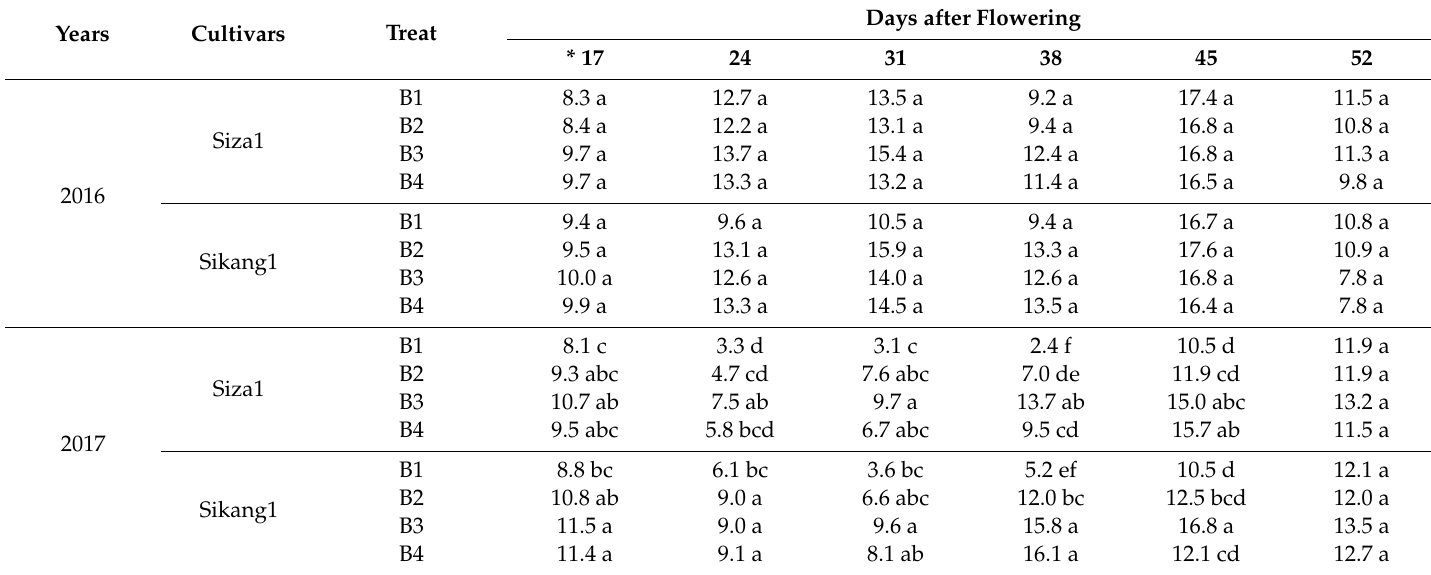
Table 6. E ff ects of the ratio of nitrogen, phosphorous, and potassium application on SOD (super oxide dismutase) content SOD ( µ g min − 1 ) of Siza 1 and Sikang 1 cotton plants in 2016 and